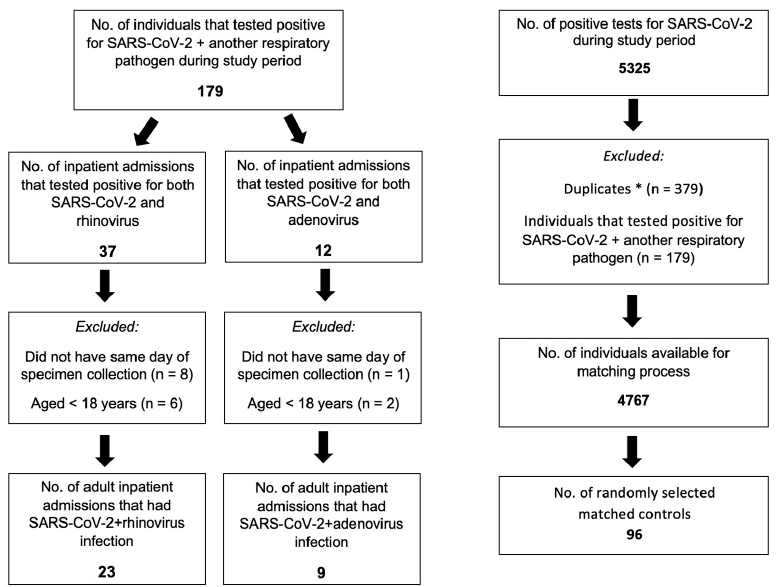
Figure 1. Patient Disposition Chart by Co-infection Status. *: If a patient tested positive more than once for SARS-CoV-2 during the study period, only the first instance of a SARS-CoV-2 positive test was eligible for selection in the analysis.